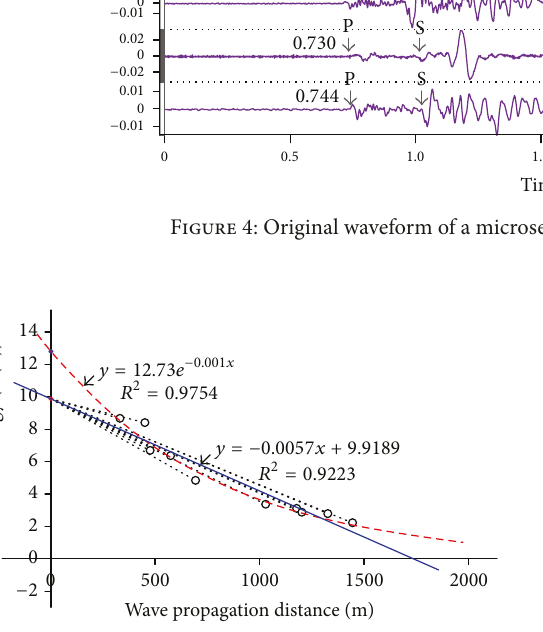
Figure 5: Attenuation of residual microseismic wave energy in coordination with the increasing propagation